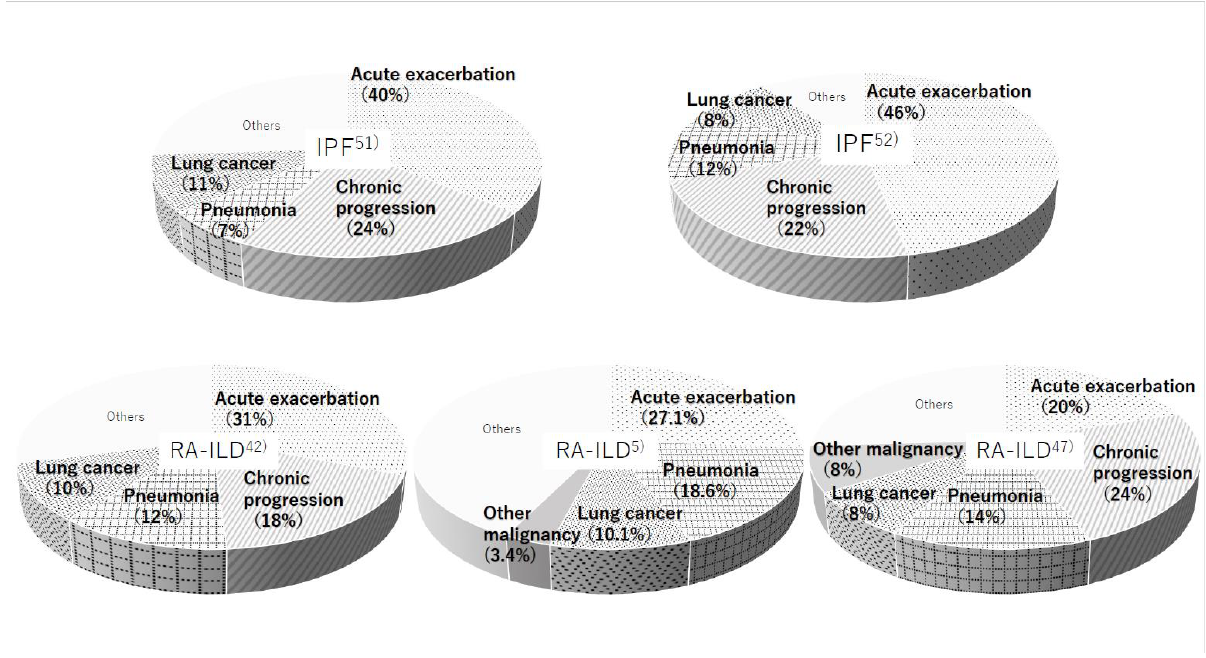
Figure 5. Causes of death were reported by five different studies in patients with idiopathic pulmonary fibrosis (IPF) ( upper row ) and RA-ILD ( lower row ).